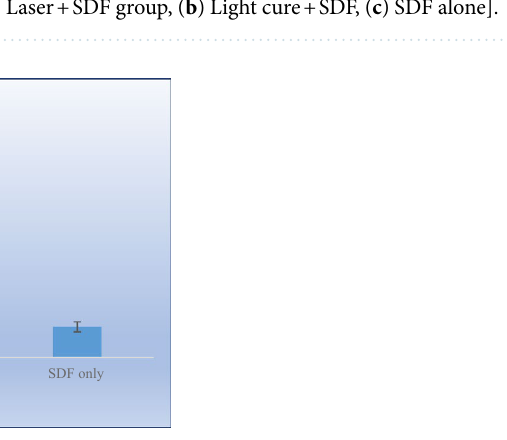
Figure 2. Mean ± SD of hardness (kgf/mm 2 ) in sound dentin below the carious lesion in the study groups.